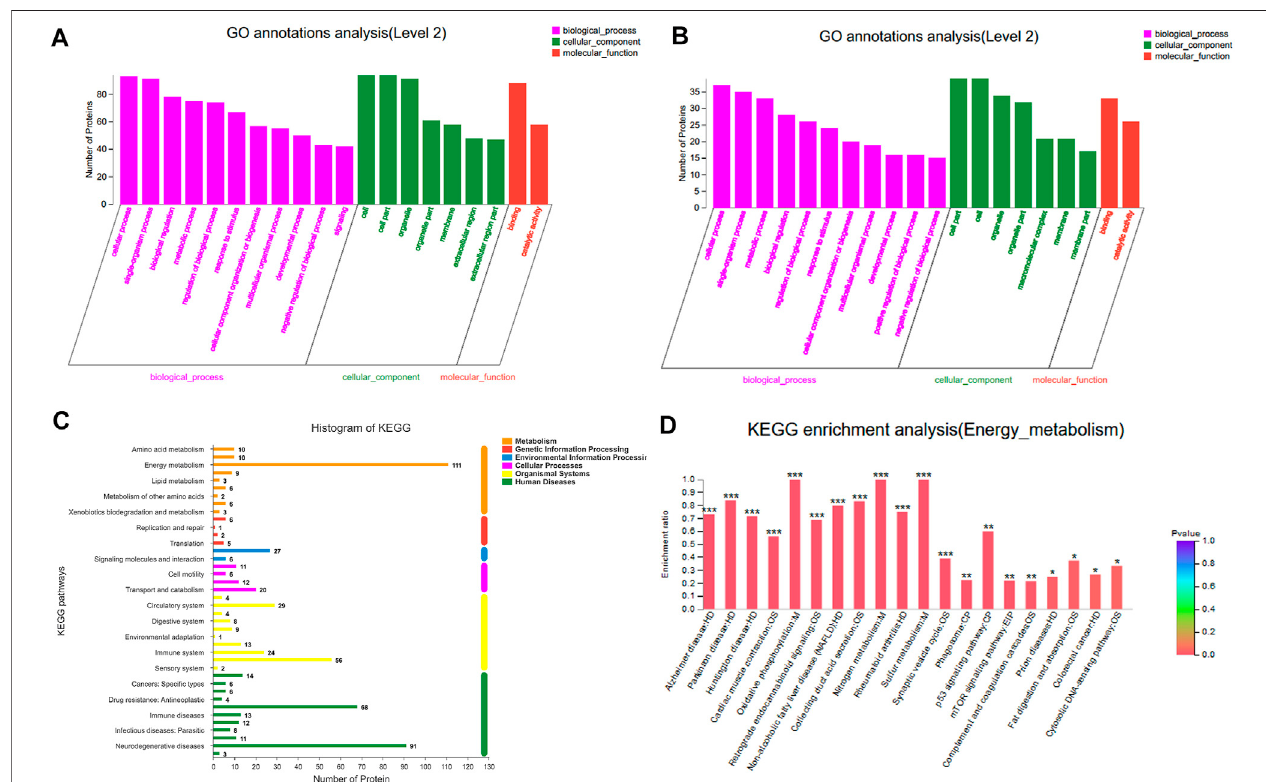
FIGURE 8 | Functional annotation and categories of DEPs. (A) GO annotations analisis of Model:Control. (B) GO annotations analisis of Treatment:Model. (C) KEGG analyses of protein functions. (D) Enrichment analysis of KEGG energy metabolism pathway.